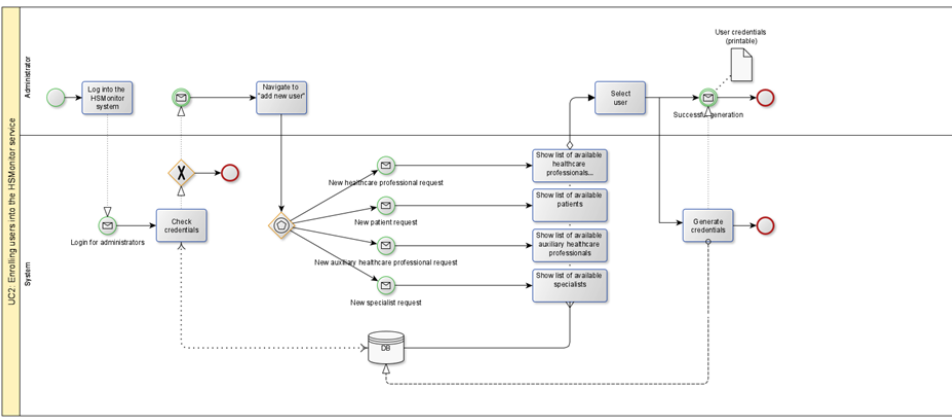
Figure 5. Example of HSMonitor process model.